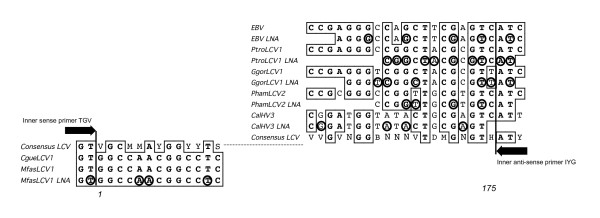
Alignment of LNA-substituted oligonucleotides. The LNAs, used in this study for specific inhibition of LCV amplification, were multiply aligned with their target sequences. The LNA-substituted bases are highlighted by circles. Identical nucleotides are boxed. For comparison, an LCV consensus sequence is shown, which was derived from all published LCV DPOL sequences. The bases 1 and 175 are the first and the last base of the sequence, which is amplified from LCV with pan-herpes DPOL primers (Bases 154668 and 154494 of the EBV B 95–8 genome [Acc. V01555], respectively). Only the 5'- and the 3'-ends are shown, the central part of the consensus sequence is represented by the dotted line. The 3'- ends of the binding regions of the inner consensus primers TGV (sense) and IYG (antisense) are indicated.